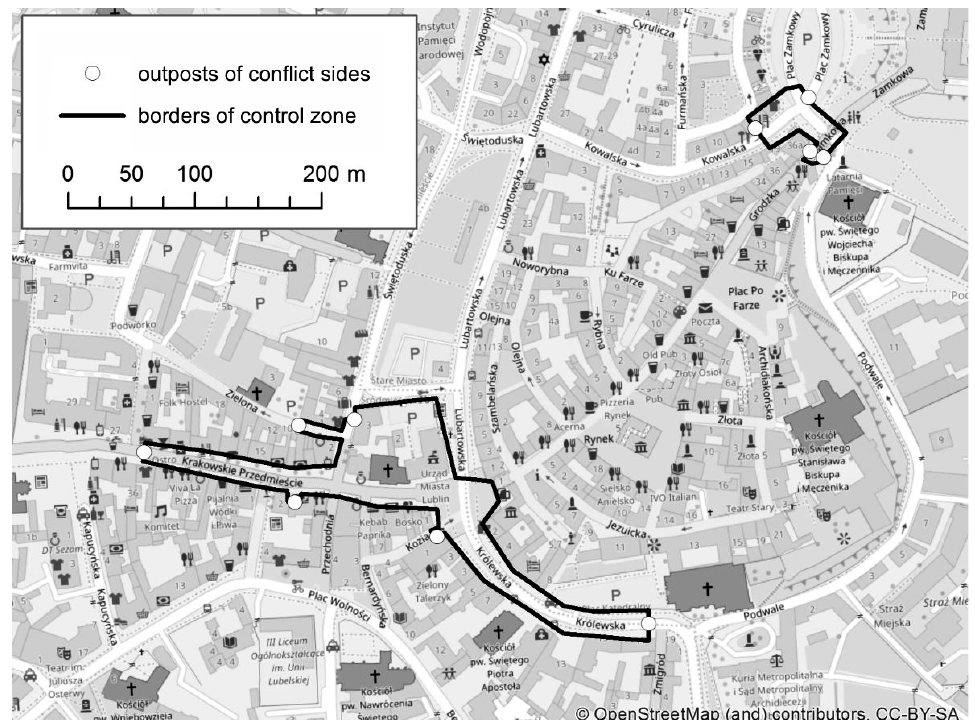
Fig. 3. Location of the outposts and approximate range of the zones controlled by both parties presented on a contemporary